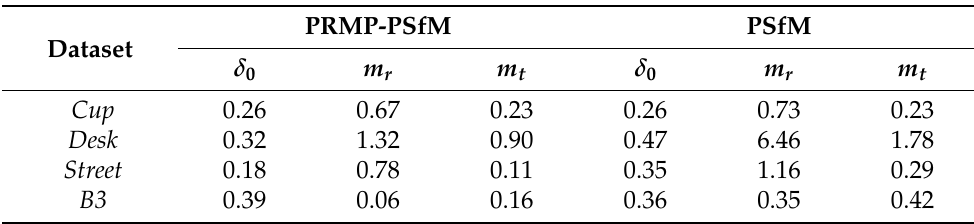
Table 5. Numerical comparison of reconstruction results between PRMP-PSfM and PSfM. δ 0 is the mean projection error, m r is the mean rotation error in degrees and m t is the mean translation error in ground-truth units × 10 − 1 .